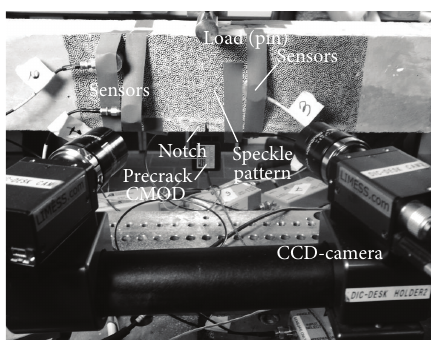
Figure 2: Experimental set-up.